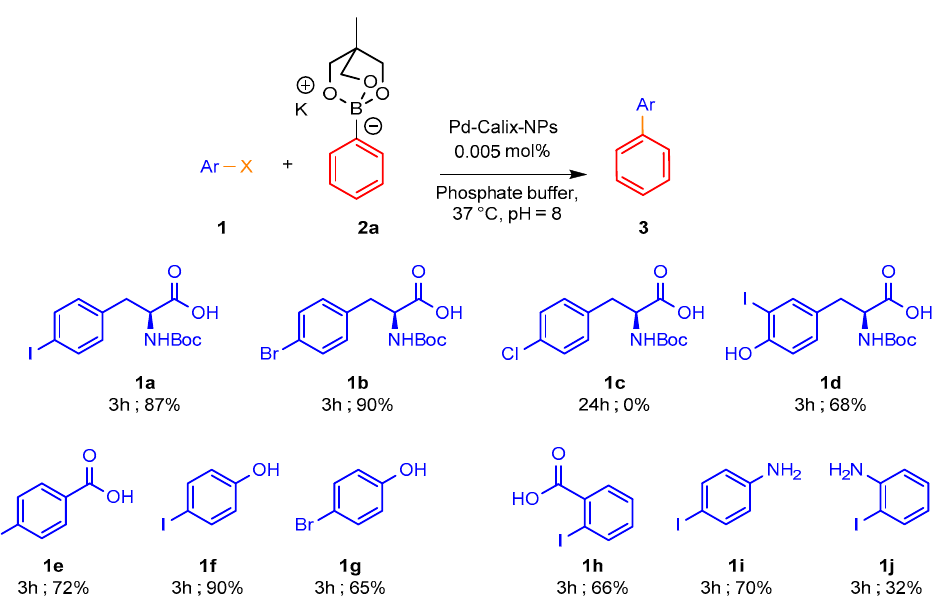
Figure 3. Reactivity of cyclic phenyltriolborate with selected water-soluble aryl halides. Aryl halide (1 equiv.), cyclic triol phenylborate (3 equiv.), Pd-Calix-NS (0.005 mol%), phosphate buffer (20 mM, pH = 8), 37 °C 3 h. Isolated yield after chromatographic purification.